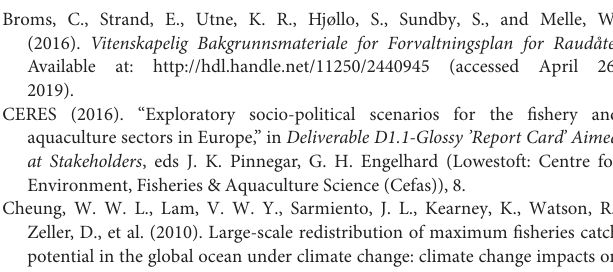
FIGURE S1 | Normalized zooplankton biomass time series from (in black) the unforced replicate, and (in orange, whole line) one of the 13 replicates that is forced with the time series of zooplankton growth. The dotted orange line is the fraction that eventually was multiplied by zooplankton growth and applied in the model system to create variability for each scenario. TABLE S1 | Overview over functional groups and species included in NoBa